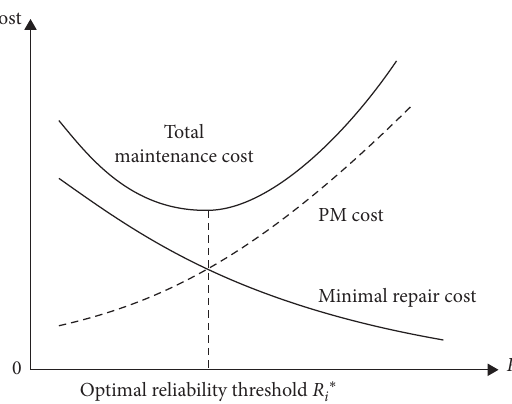
Figure 3: The curve of system maintenance cost.